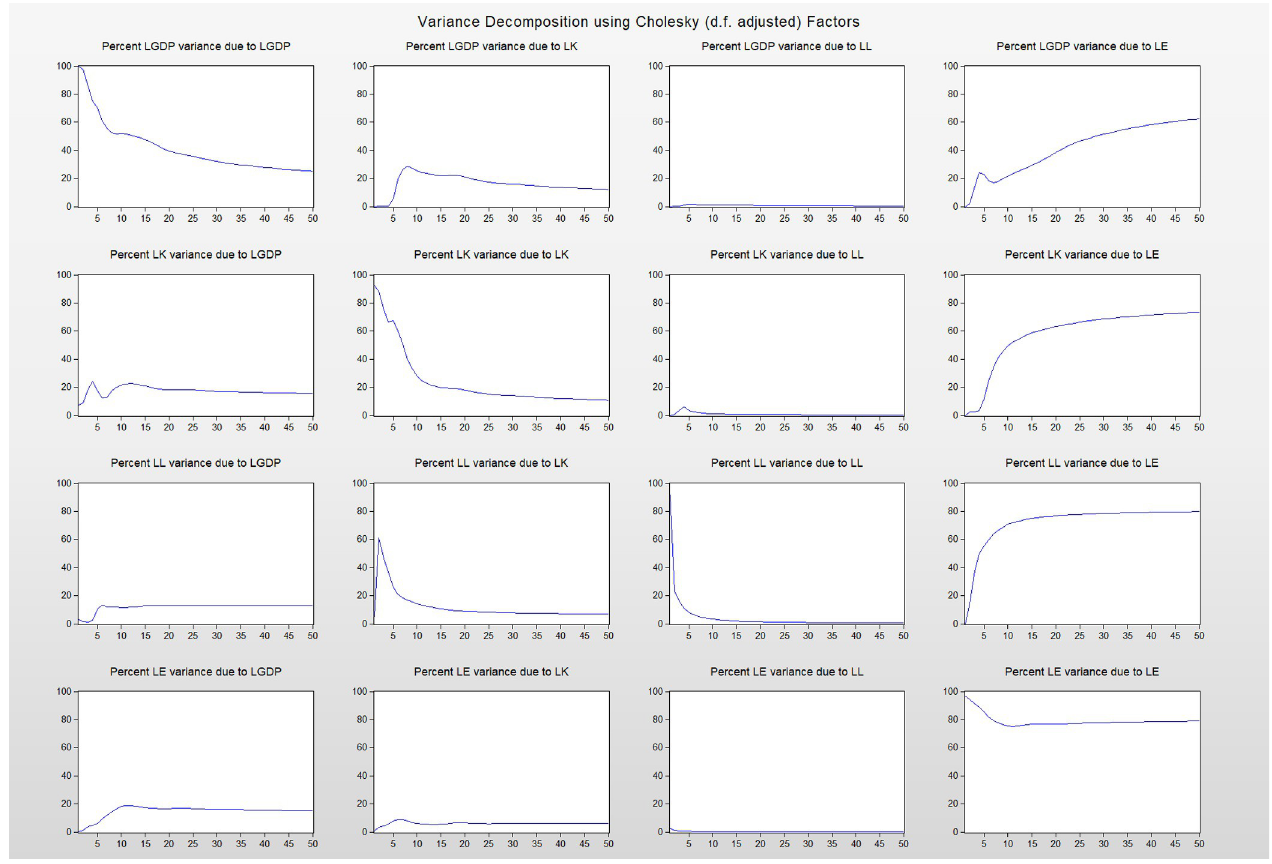
Fig 9. Diagram of variance